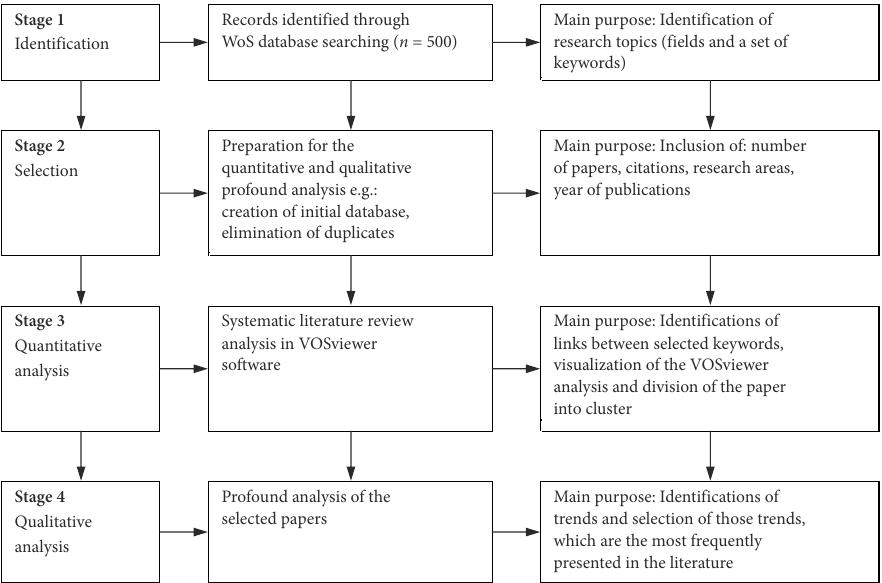
Figure 2. Systematic literature review